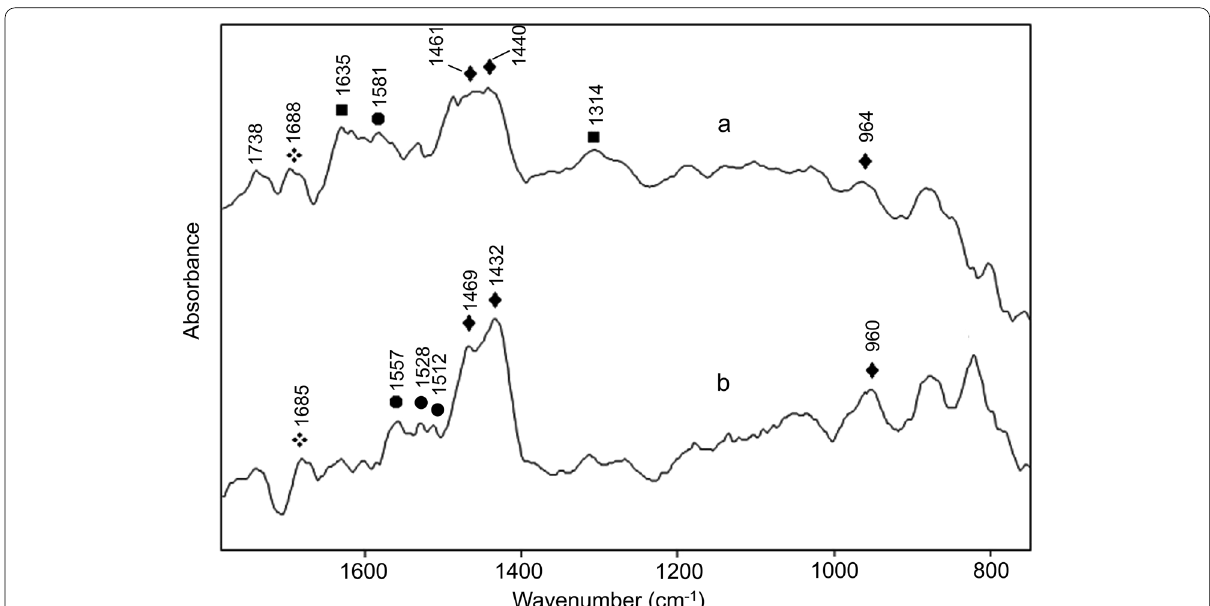
Fig. 3 Reflection micro-FTIR spectra, elaborated by the Kramers-Kronig transform, obtained from two different micro-areas of the colour layer in the cross-section of a fragment taken from a blue area of the painting. Legend: “ ♦ ”, azurite; “ ● ”, metal soaps; “ ■ ”, oxalates; “ ❖ ”, possible natural resin. The band at about 1740 cm − 1 is probably due to the embedding resin